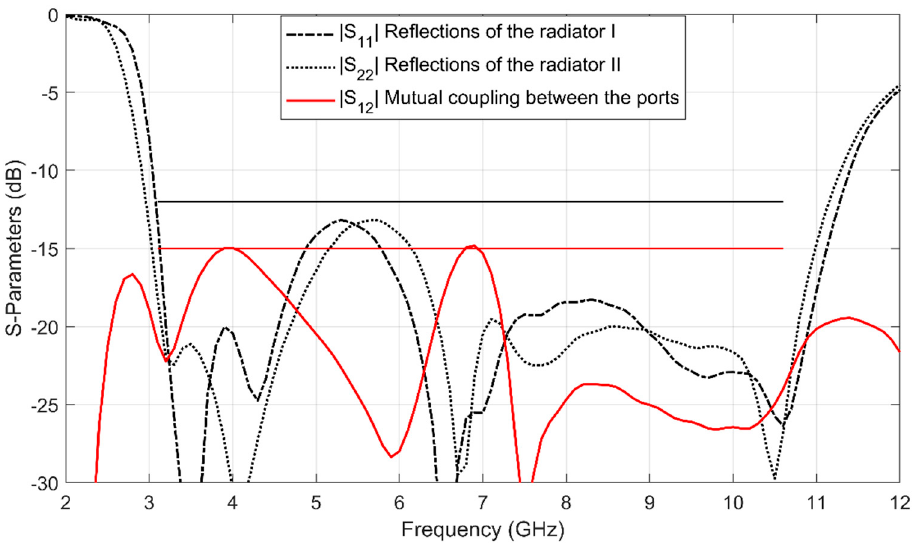
Figure 9. S-parameter characteristics of the compact UWB MIMO antenna: responses of the optimal design x ∗ . The black solid straight line is the specification ( − 12 dB) for reflection of each radiator. The red solid straight line is the specification ( − 15 dB) for mutual coupling.